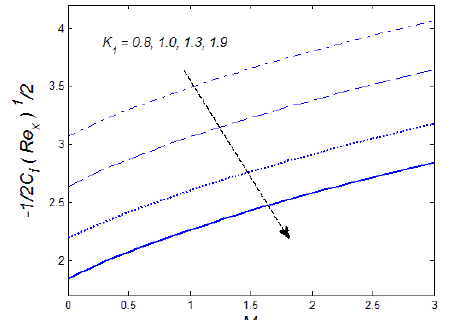
Figure 13. Upshot of K 1 and M on wall shear stress − 1